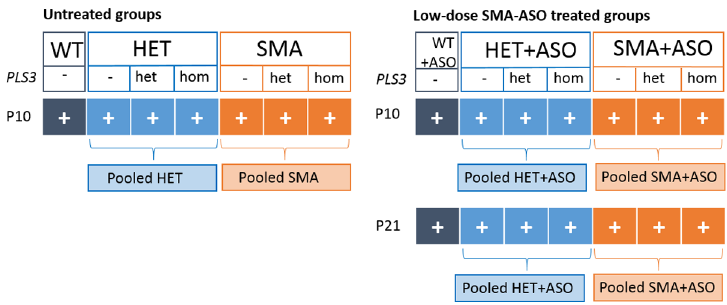
Fig 1. Schematic overview about the mouse genotypes and time points of protein level